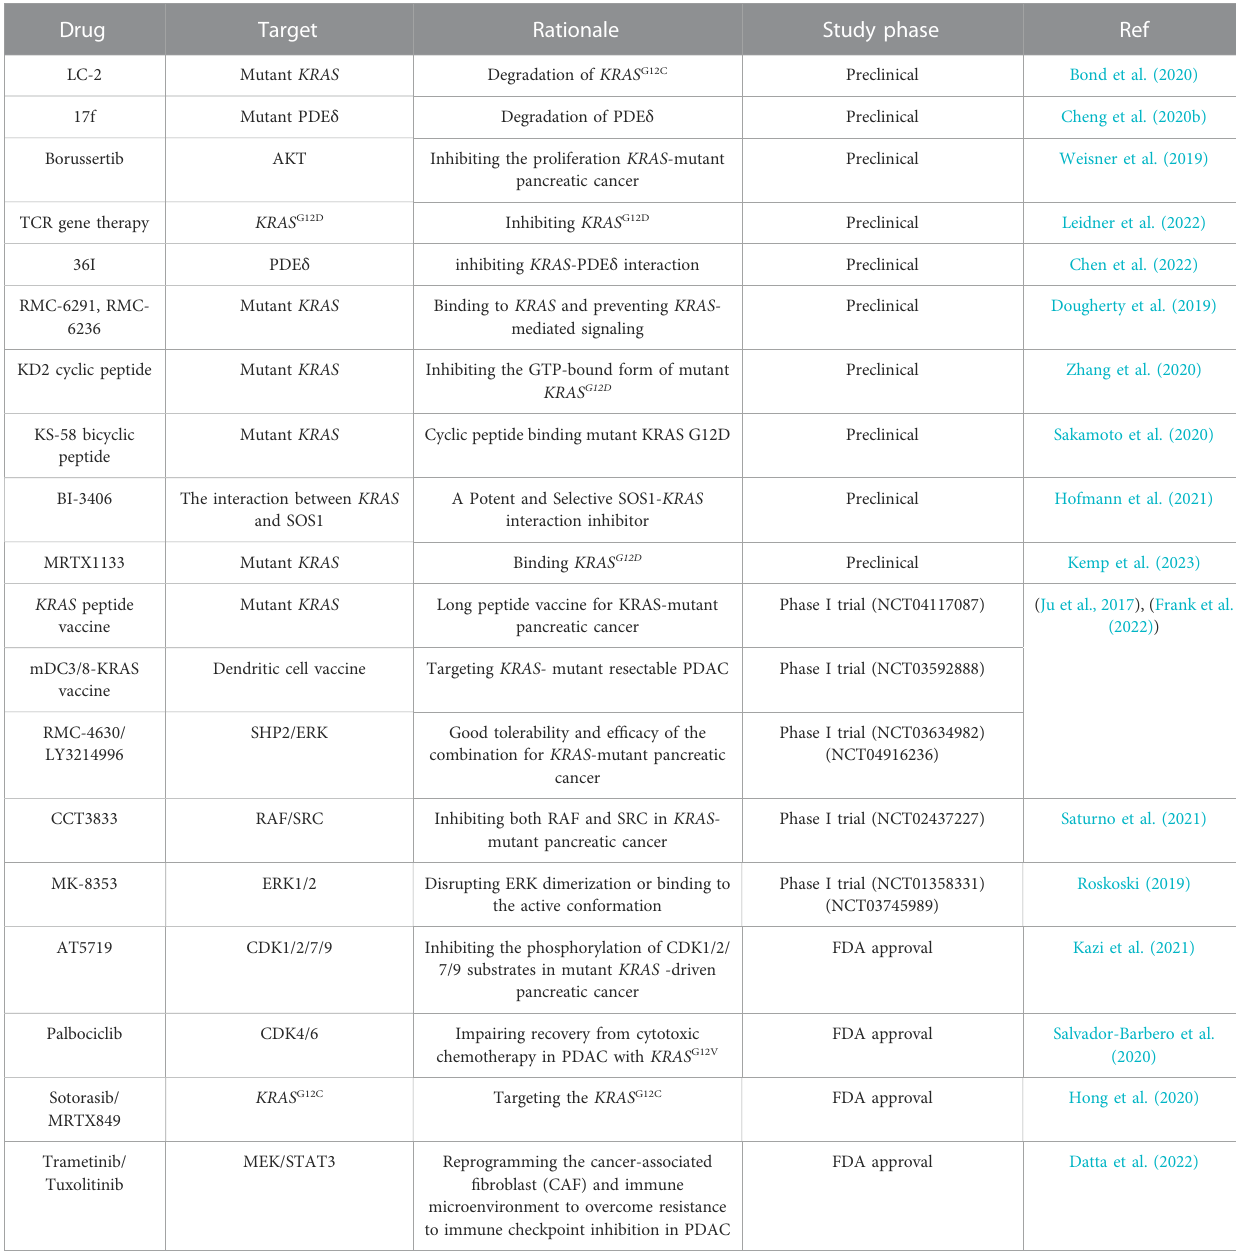
TABLE 1 Therapies for PDAC directly focused on KRAS mutation or indirectly on related effector.